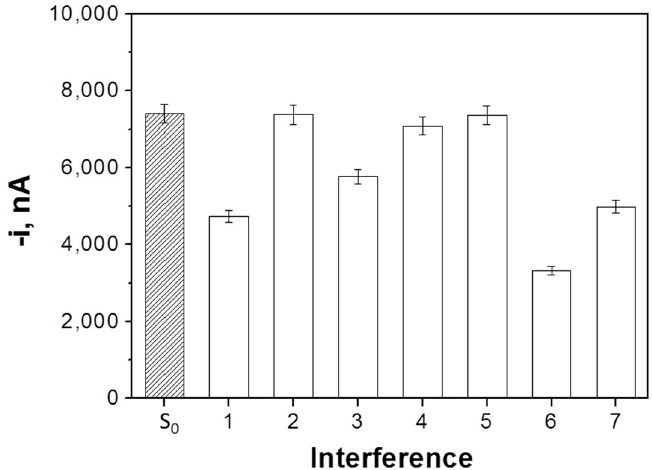
Figure 4. Selectivity of the developed competitive DNA/RNA hybridization-based biosensor for determination of miRNA-21. Amperometric responses measured in the absence (S 0 ) and in the presence of 5.0 nM miRNA-21 (1), 1-m (c) (2), 1-m (t) (3), NC1 (miRNA-205) (4), NC2 (miRNA-122) (5), and mixture solutions containing the target miRNA and the two 1-m (6) or the target miRNA and the two non-complementary (NC) sequences (7). Error bars estimated as three times the standard deviation of three replicates.